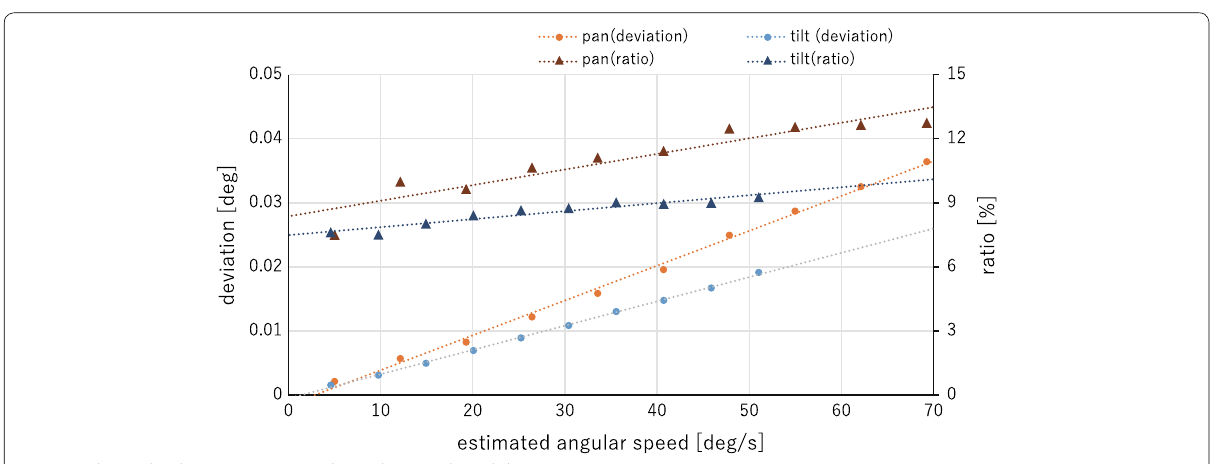
Fig. 9 Relationship between estimated angular speeds and deviation